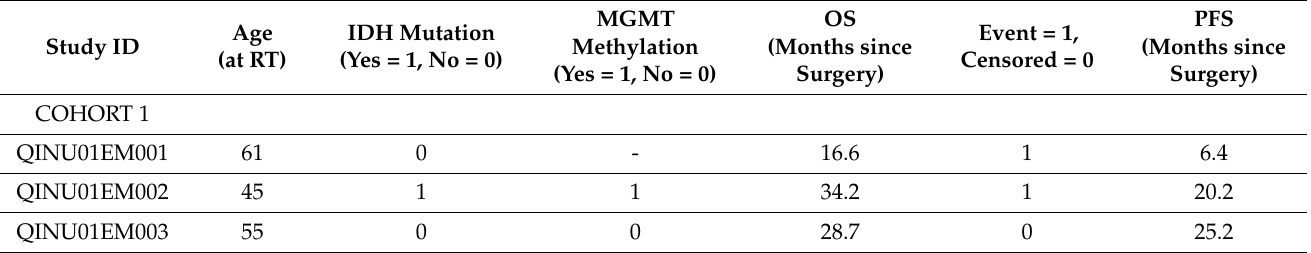
Table A1. The characteristics and outcome for each patient enrolled in the